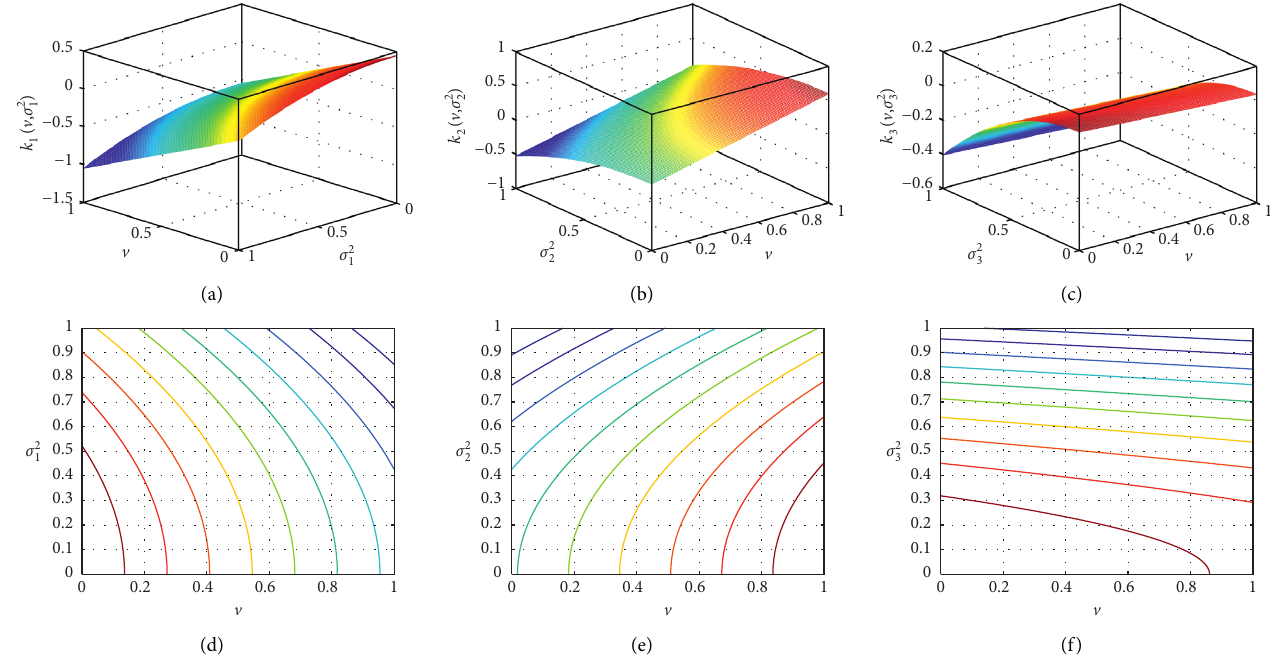
Figure 2: k phase plan of k